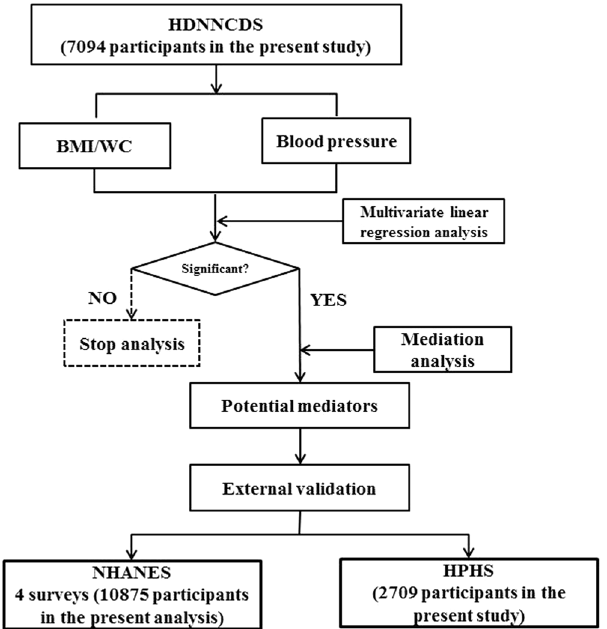
Figure 1. Procedure to systematically associate body mass index or waist circumference with blood pressure by potential